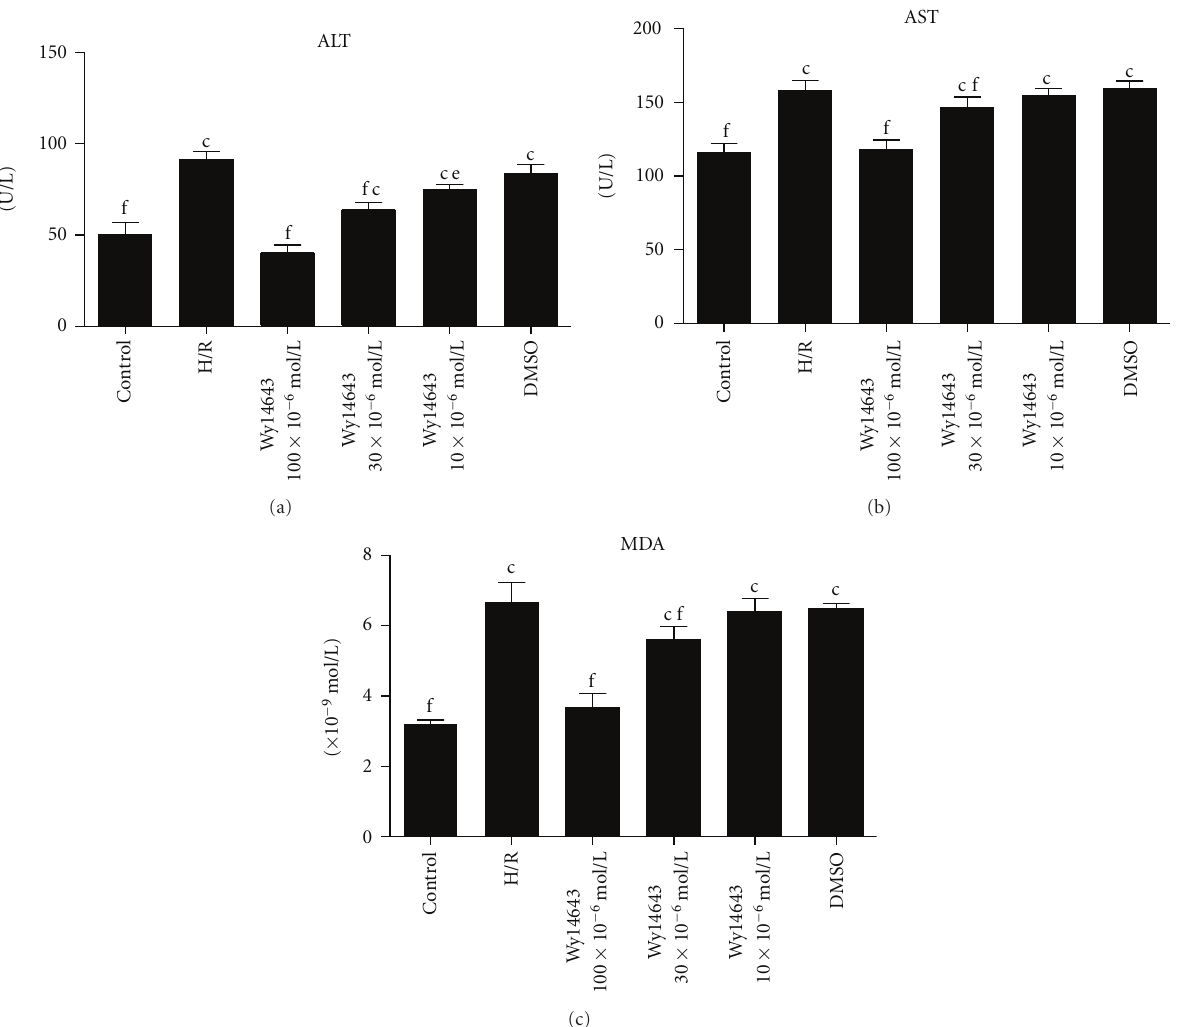
Figure 1: (a) ALT in di ff erent groups (Mean ± SD, n = 6). After 4 h of hepatocellular hypoxia and 10 h of reoxygenation. The levels of ALT in hepatocytes medium were determined. c P < 0 . 01 versus control group; e P < 0 . 05, f P < 0 . 01 versus H/R group. (b) AST in di ff erent groups (Mean ± SD, n = 6). After 4h of hepatocellular hypoxia and 10h of reoxygenation. The levels of AST in hepatocytes medium were determined. c P < 0 . 01 versus control group; f P < 0 . 01 versus H/R group. (c) MDA in di ff erent groups (Mean ± SD, n = 6). After 4h of hepatocellular hypoxia and 10h of reoxygenation. The levels of MDA in hepatocytes determined. c P < 0 . 01 versus control group; f P < 0 . 01 versus H/R